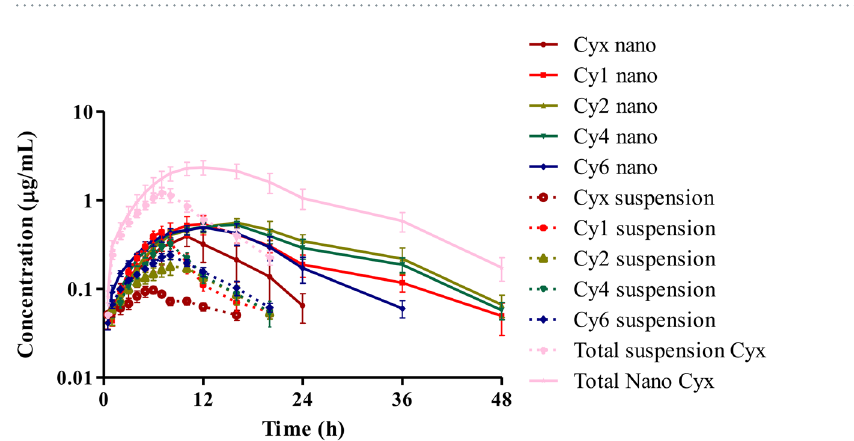
Figure 4. Release profiles of bulk Cyx and Cyx nanosuspension in PBS buffer solution. (n = 6, pH = 7.4).